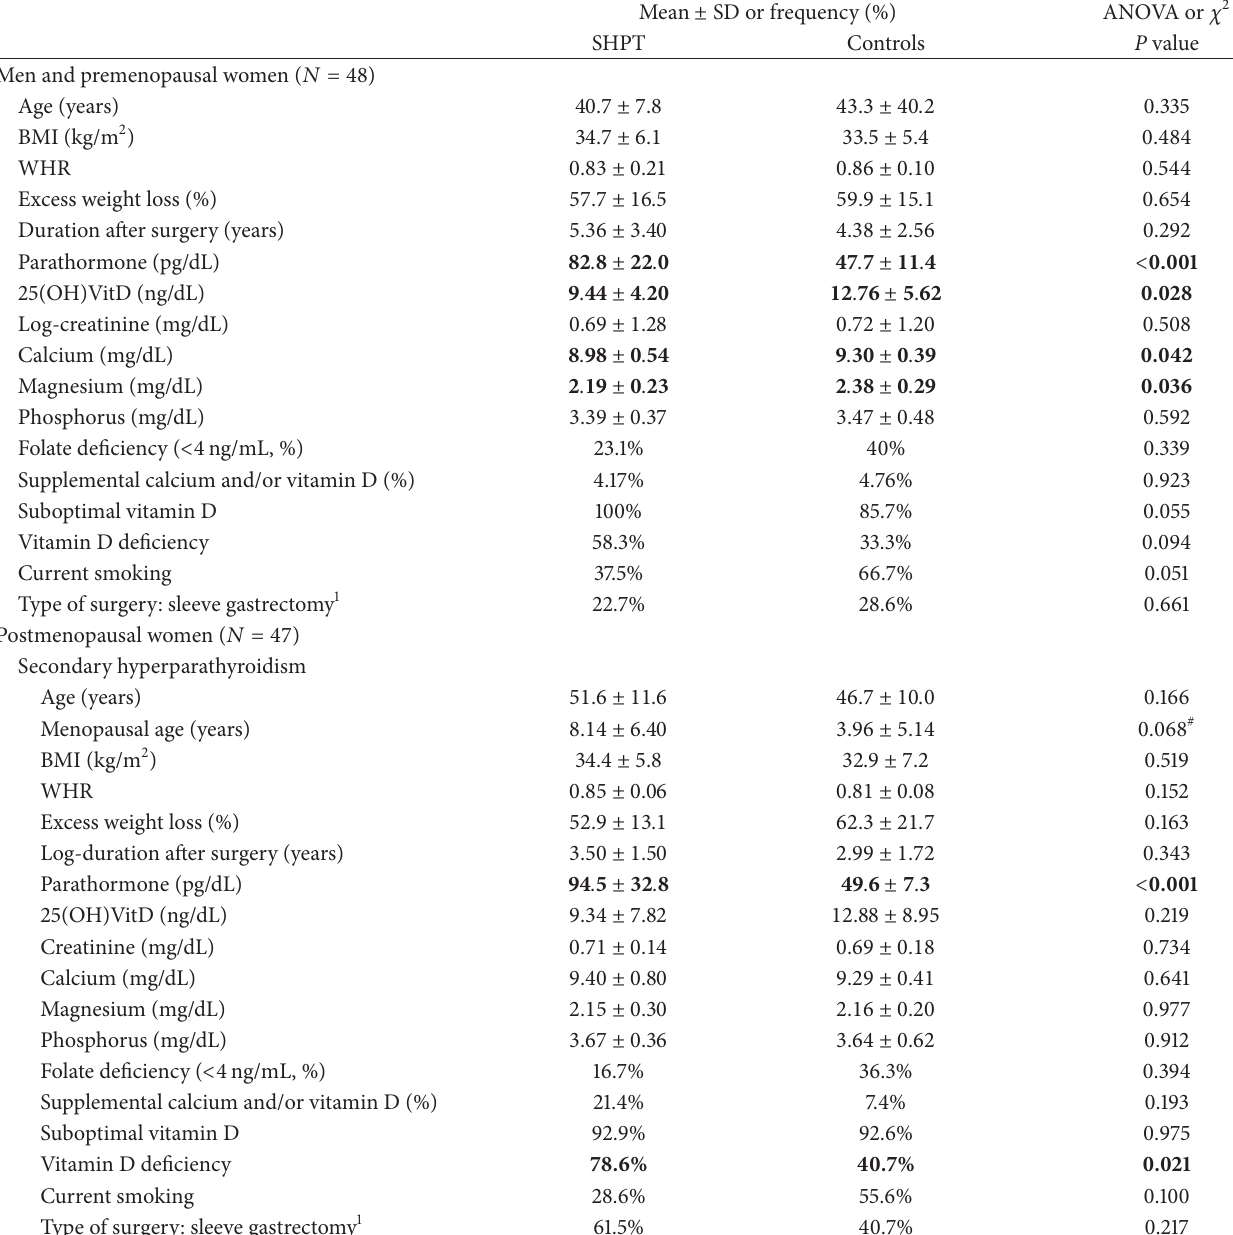
Table 2: Comparison of main anthropometric and biochemical parameters according to the presence of secondary hyperparathyroidism after surgery, independently for men/premenopausal women and for postmenopausal